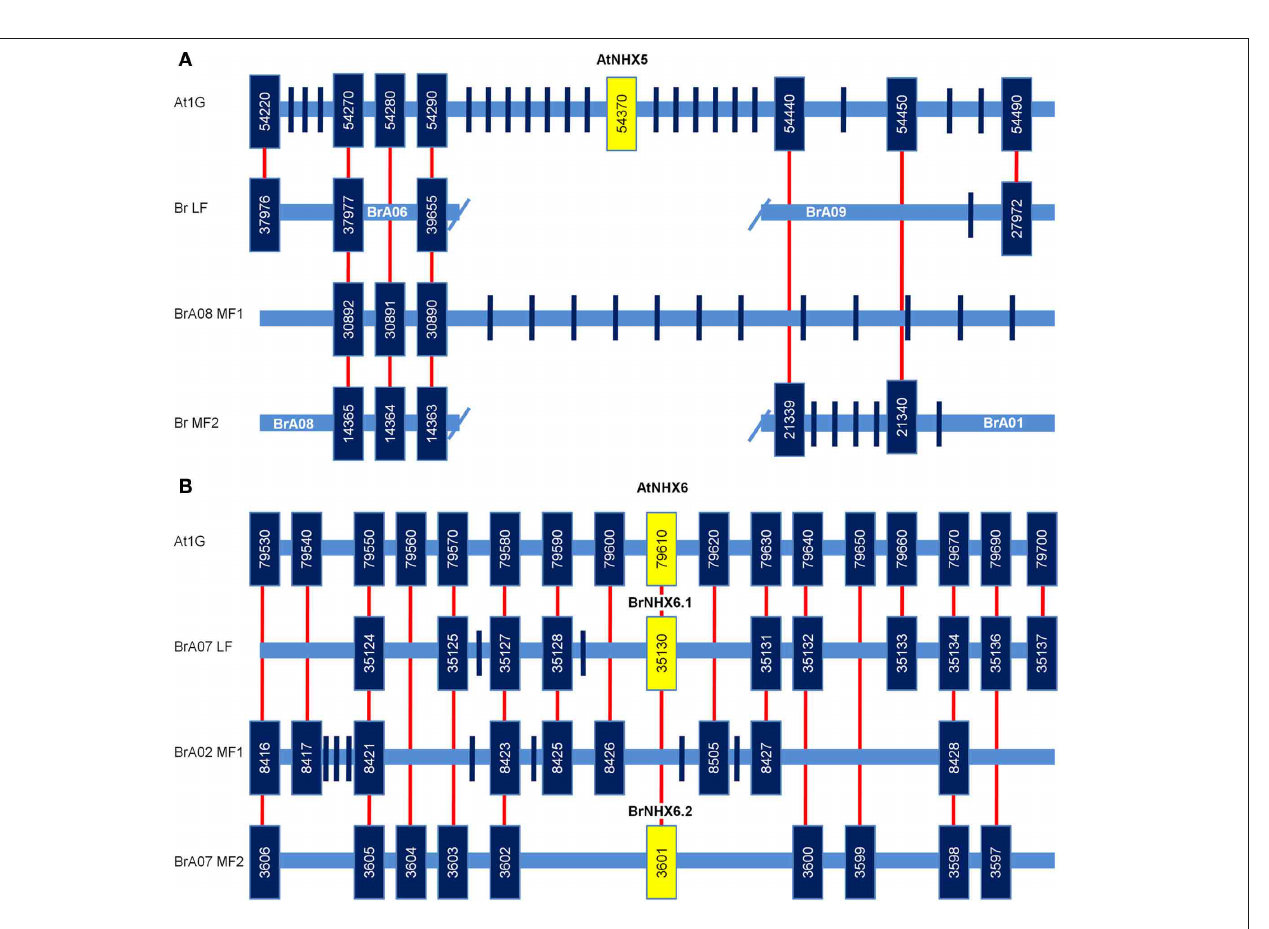
FIGURE 4 | Microsynteny of AtNHX5 and AtNHX6 and conserved co-linearity in B. rapa . Comparison of co-linearity between AtNHX5 (A) and AtNHX6 (B) (highlighted in yellow) in the Arabidopsis genome and the least fractionated (LF), medium fractionated (MF1) and most fractionated (MF2)